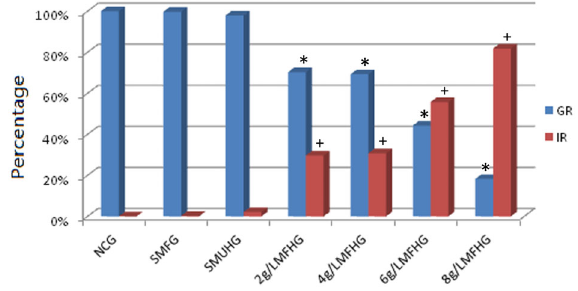
Figure 4. MTT histogram of SMMC-7721 cells after treatment. GR: growth rate; IR: inhibition rate; NCG: control group A (RPMI 1640 culture medium only); SMFG: control group B (RPMI 1640 culture medium and radiation); SMUHG: spiking group (8 g/L Fe 2 O 3 , no radiation); MFHG: magnetic fluid hyperthermia groups with Fe 2 O 3 concentrations of 2, 4, 6, and 8 g/L,